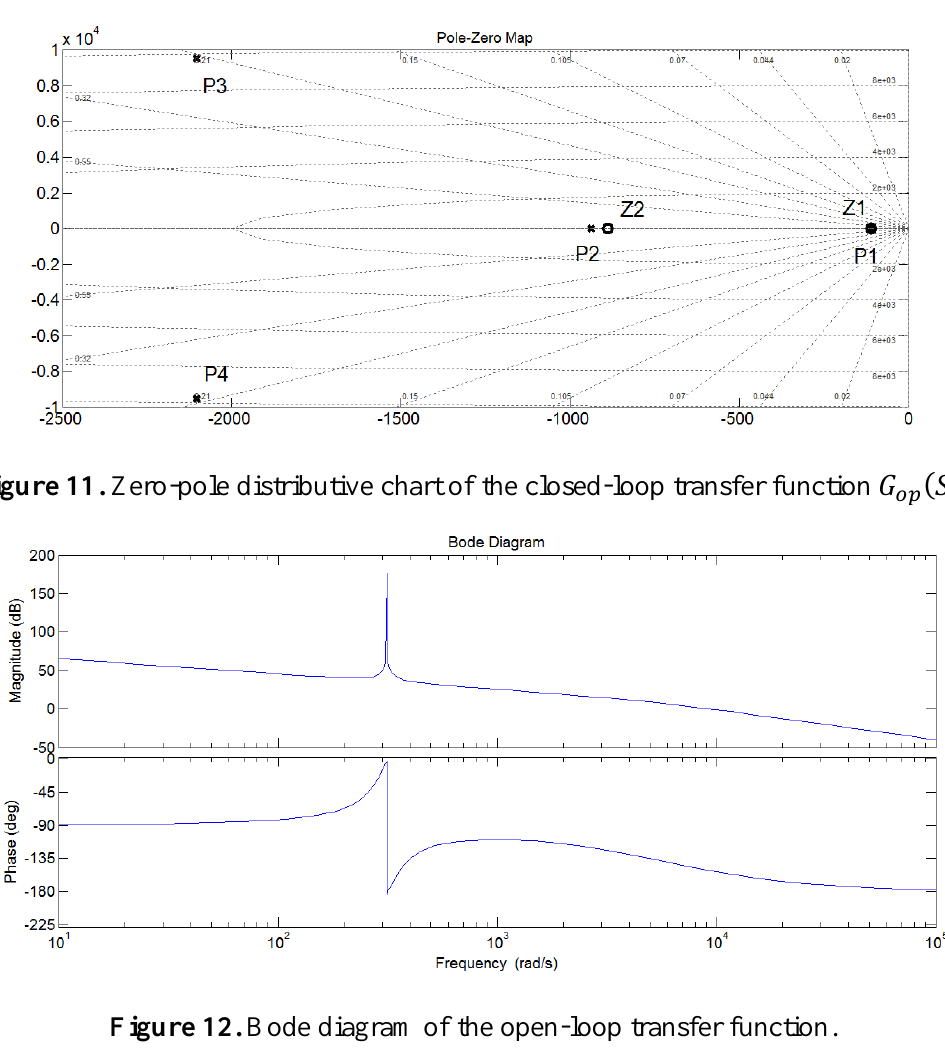
Figure 12. Bode diagram of the open-loop transfer